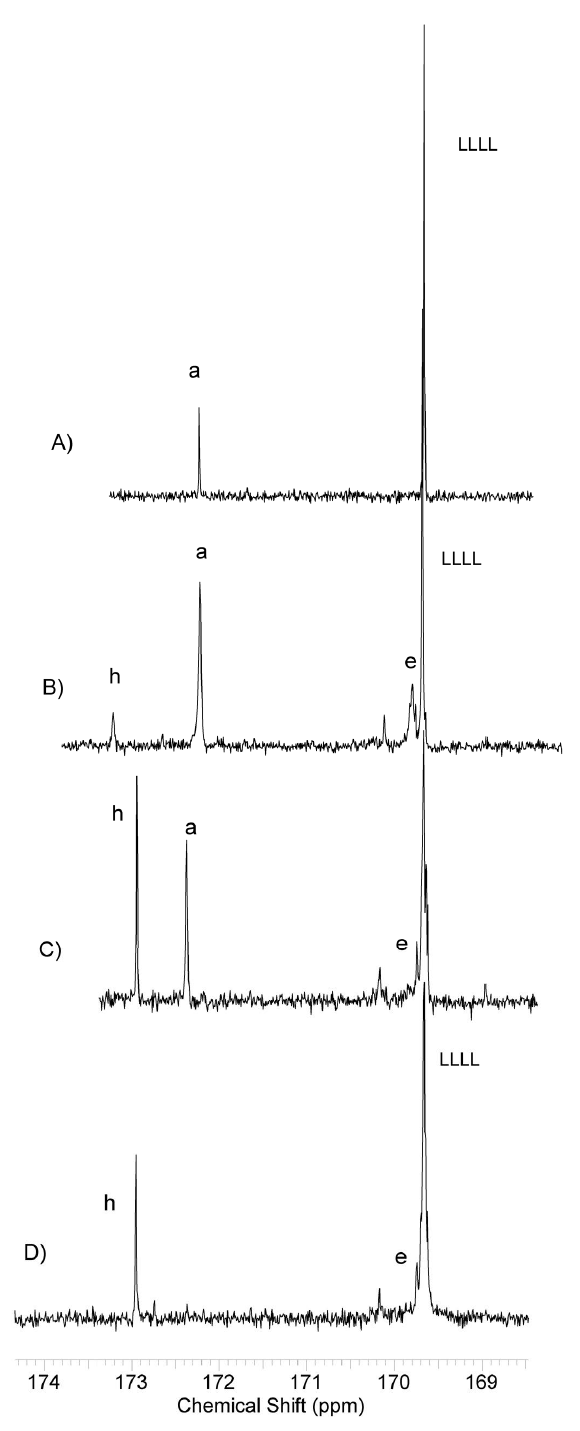
Figure6. 13 CNMRspectra(carbonylregion, inCDCl 3 )of( A )NG7—poly( l -lactide)– block –poly(butylene succinate), ( B ) NG 20—poly( l -lactide)- block -poly(butylene succinate– co –butylene citrate), ( C ) NG51—poly( l -lactide)– block –poly(butylene succinate– co –butylene citrate) and ( D ) NG53—poly( l -lactide)– block –poly(butylene citrate). Where; h, e—signal carbonyl carbons of butyl citric units, a—signal of carbonyl carbons of butyl succinic units, LLLL—signal of carbonyl carbons of lactidyl